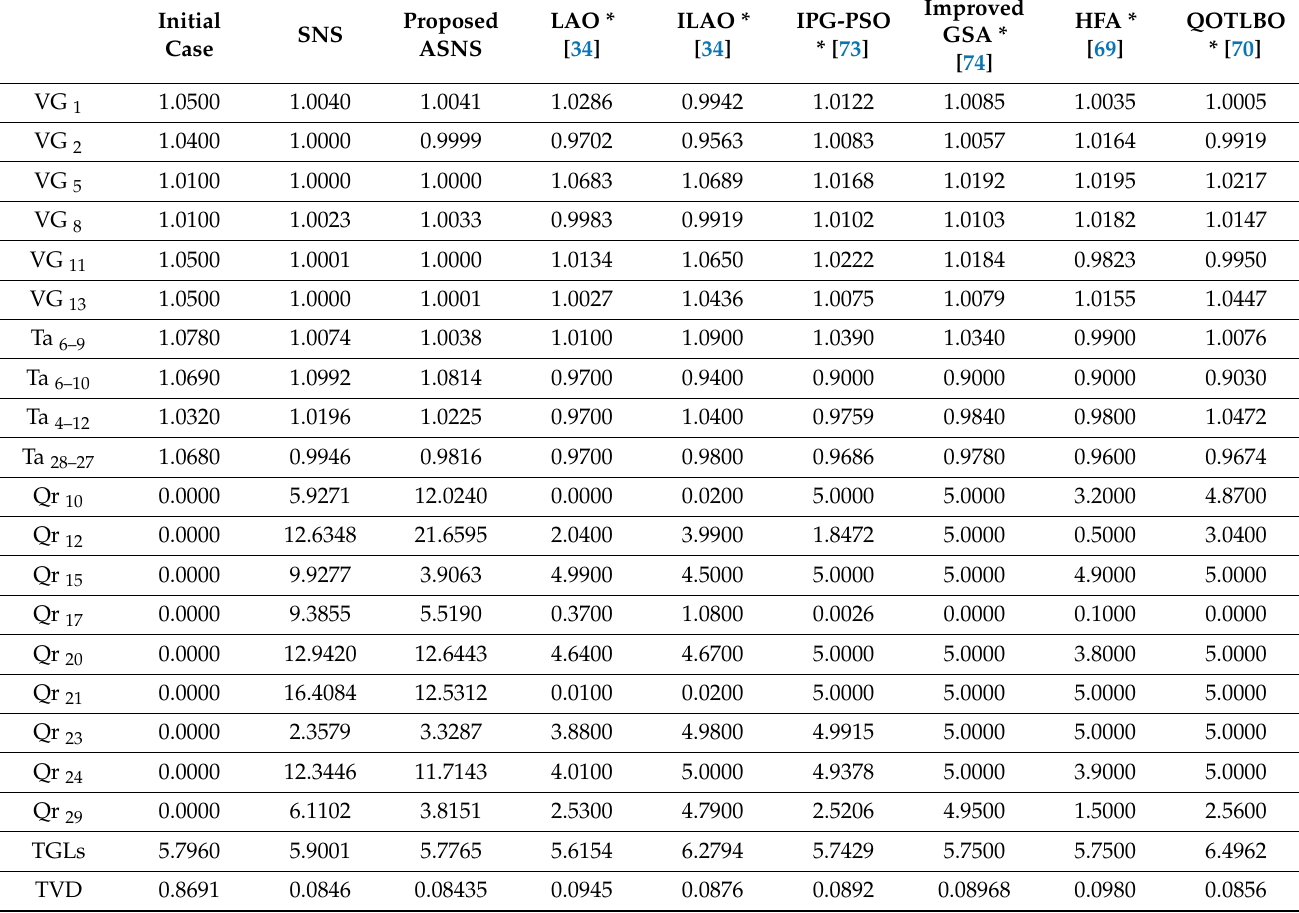
Table 3. Optimal results for Case 2 of the IEEE 30-bus